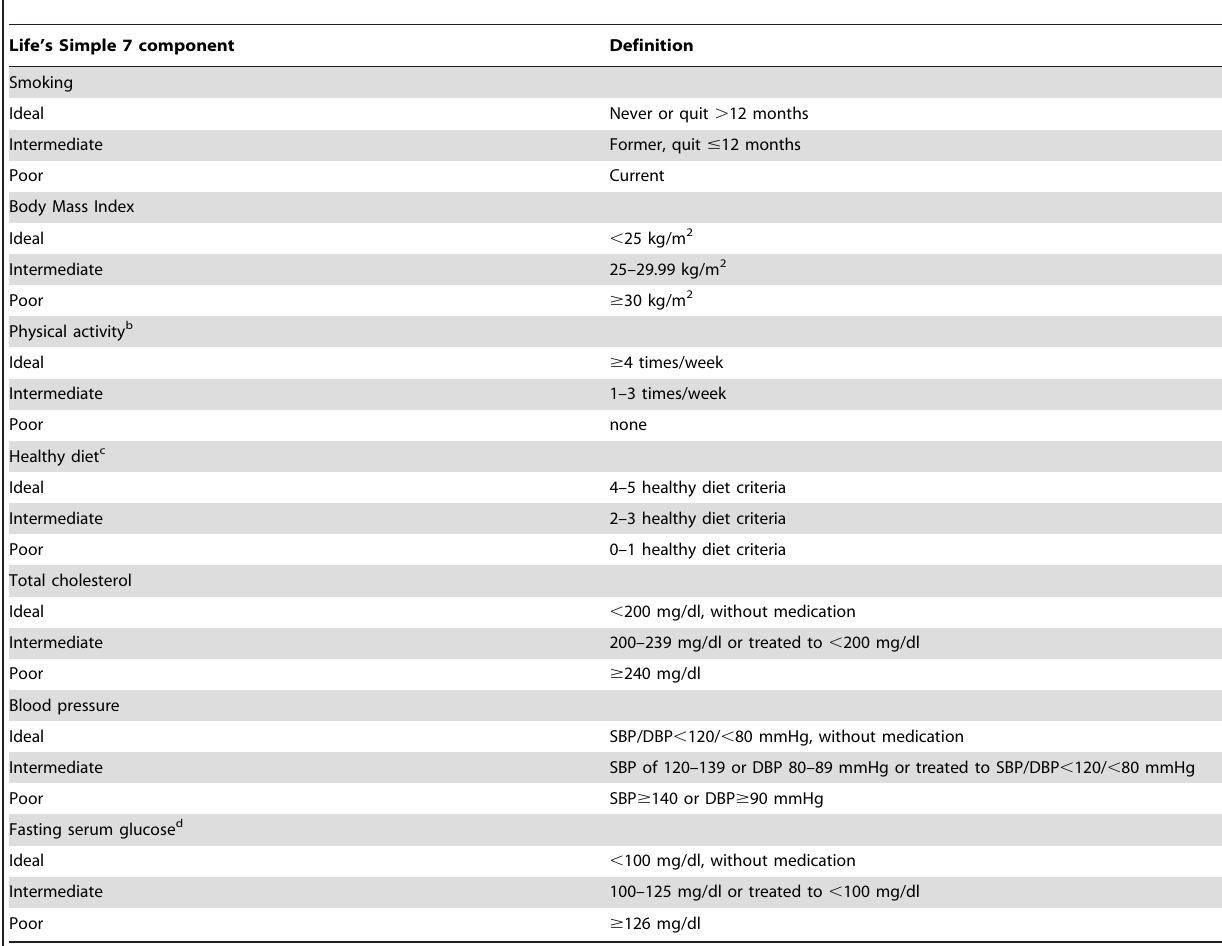
Table 1. Definitions of the American Heart Association’s Life’s Simple 7 Components